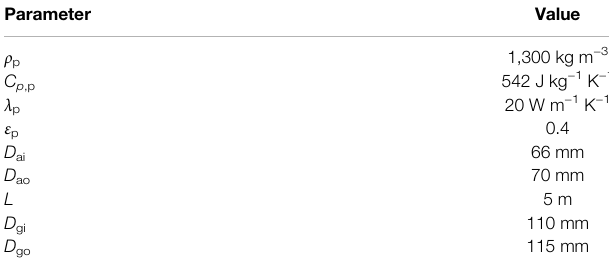
TABLE 1 | Relevant structural and physical parameters of SPTR (Ma et al., 2018).